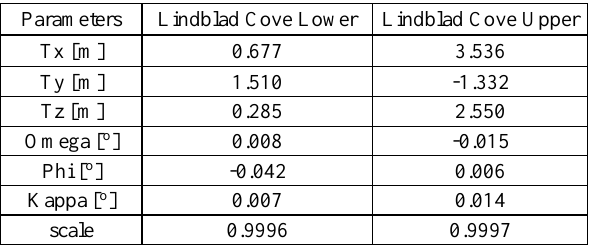
Table 5. Transformation parameters for Lindblad Cove Lower and Upper from surface matching algorithm.